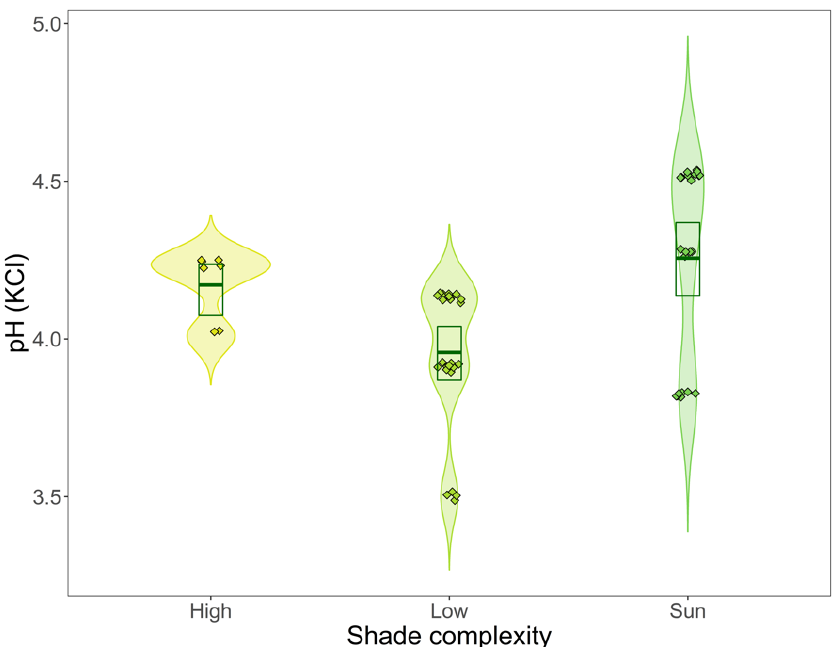
Figure 3. pH of soil samples from 56 coffee home gardens in West Java in relation to shade complexity of gardens (High: >10% shade cover and ≥5 shade tree species; Low: >10% cover and <5 shade tree species; Sun: <10% shade cover). Data are model predicted values from generalised linear models, and boxes dictate 95% confidence intervals.